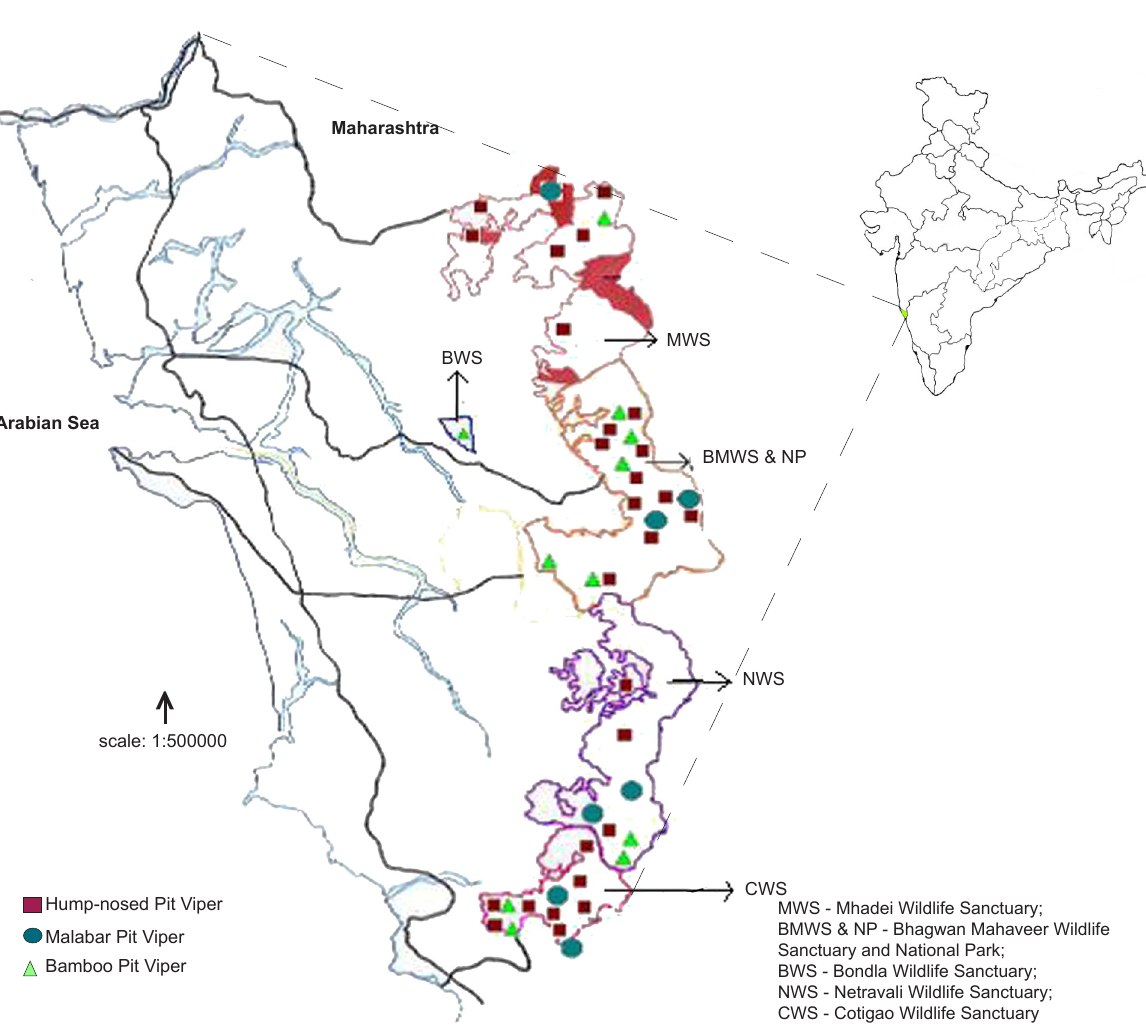
Figure 1. Map of Goa showing the distribution of pit viper species in the study